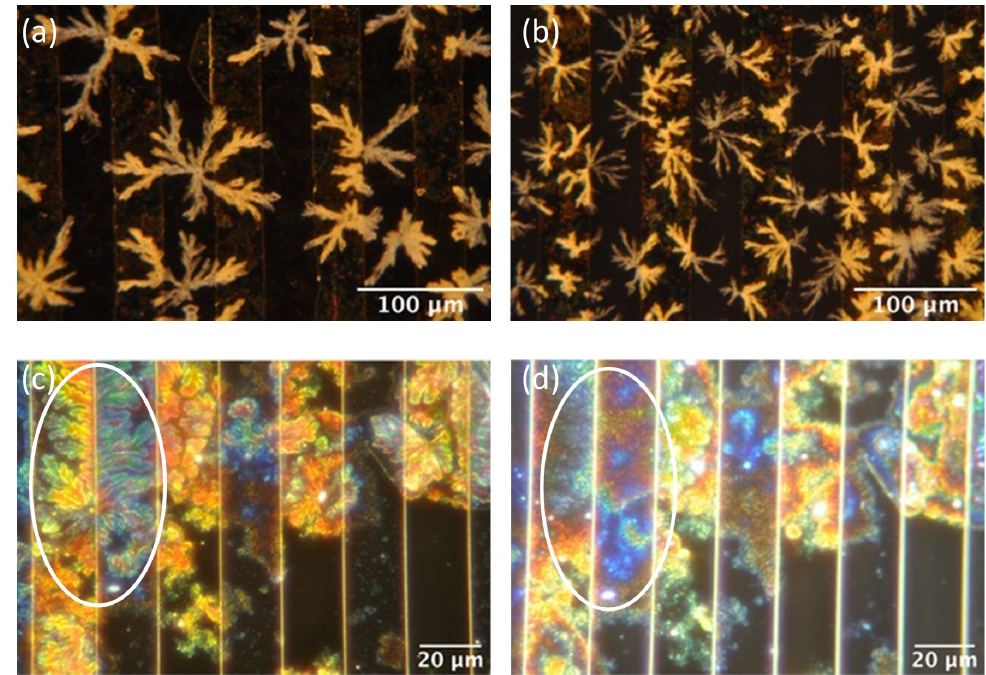
Figure 5. Dark-field optical microscope images of 1 deposited on gold interdigitated electrodes ( a , b ). ( c , d ) Dark- field optical microscope images before and after rising with water, respectively. White circle highlights the removal of adsorbed dendrimeric shapes.